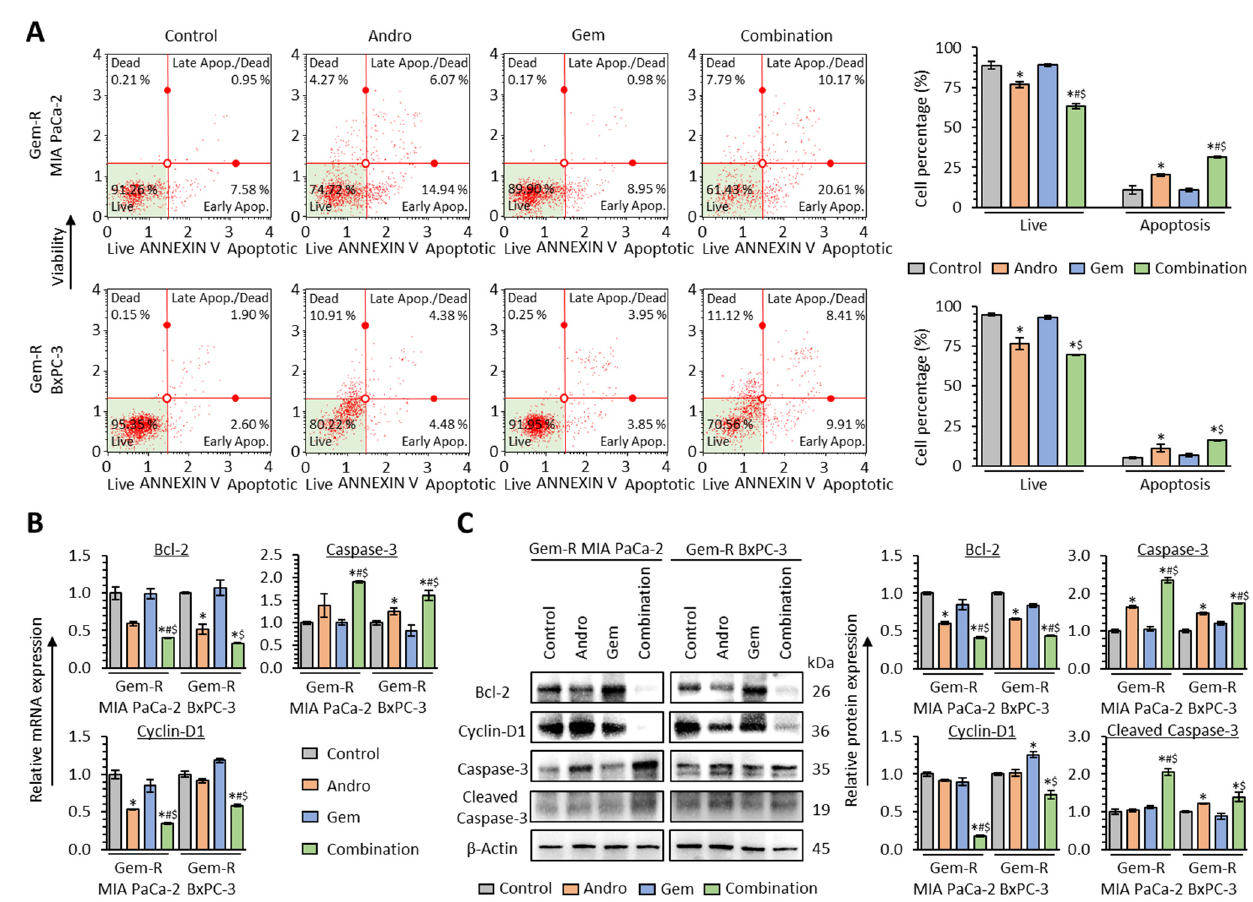
Figure 4. Andrographis and Gemcitabine enhance cellular apoptosis in Gemcitabine-resistant PDAC cells. ( A ) Representative images of cells undergoing apoptosis in Annexin V binding assay following treatment with Andro, Gem, and their combination for 48 h in Gem-R PDAC cells. The average ratio (column) ± SD of live and apoptotic cells is indicated (* p < 0.05 vs. control, # p < 0.05 vs. Andro, $ p < 0.05 vs. Gem). ( B ) qRT-PCR analyses of apoptosis-related genes (Bcl-2, Cyclin-D1, and Caspase-3) in Gem-R PDAC cells following treatment with Andro, Gem, and their combination for 48 h. Relative expression was calculated using β -Actin mRNA expression as an internal control.